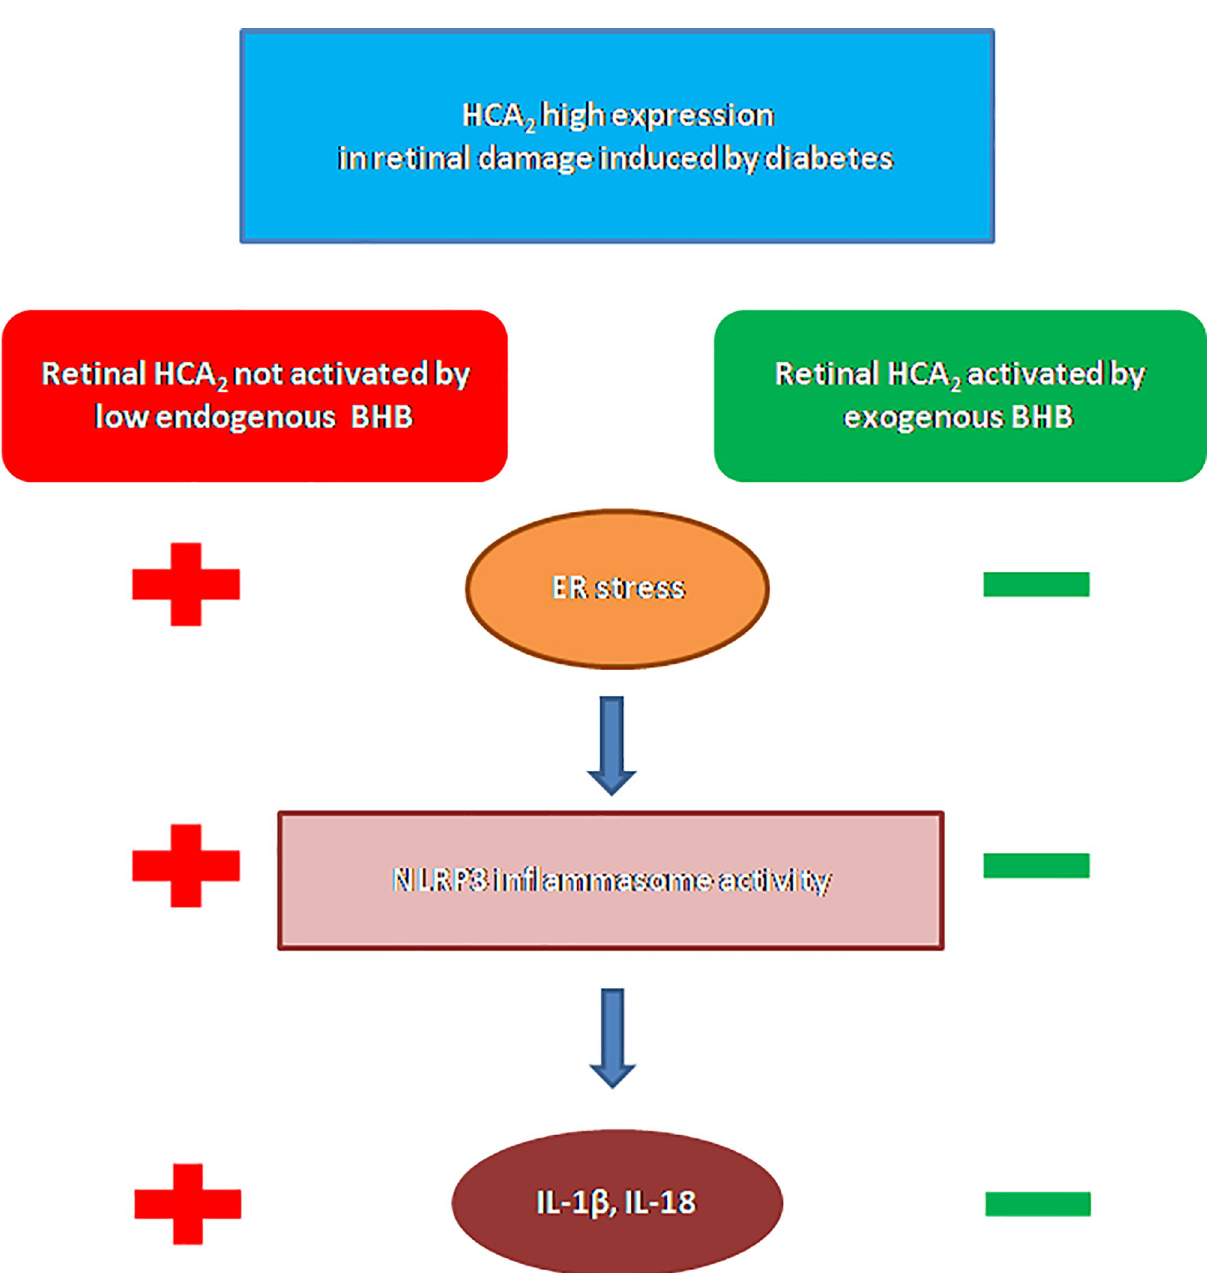
Fig 6. HCA 2 signaling and activation by BHB in retinal damage induced by diabetes. Although HCA 2 expression is increased in diabetic retinal damage, the low endogenous BHB levels are not able to activate the HCA 2 receptors. This results in high levels of ER stress and, consequently, of NLRP3 inflammasome activity, characterized by increased secretion of IL-1 β and IL-18. Once BHB is systemic administered, HCA 2 anti-inflammatory properties are exhibited in the reduction of ER stress, NLRP3 inflammasome activity and proinflammatory cytokines IL-1 β and